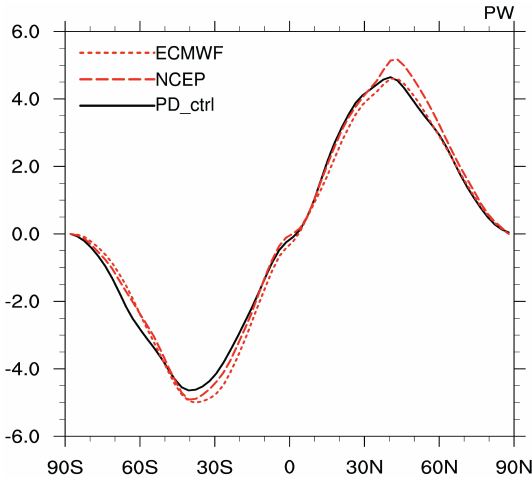
Fig. 4. Atmospheric heat transport for PD ctrl, ECMWF